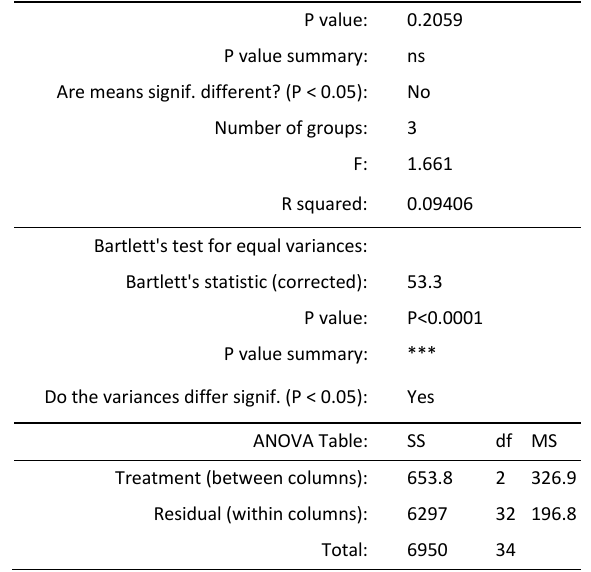
Table 3. Result of one-way analysis of variance of NIRS, TCD and REG during breath holding, hyperventilation and CO 2 inhalation.